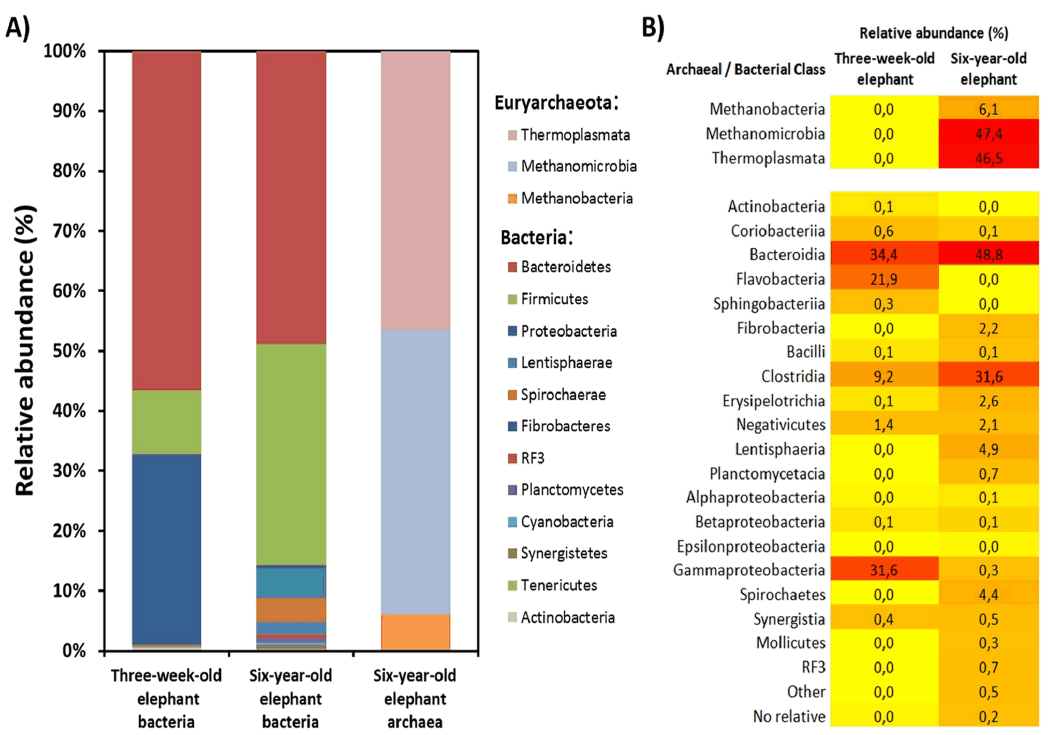
Figure 2. Relative abundances of different phyla and classes in the two elephant feces samples. A: Relative abundance of phyla in the feces of the three-weeks-old and the six-years-old Asian elephant based on 16S rRNA gene sequences. For the three-weeks-old elephant no Archaea were observed. B: Phylogenetic comparison on class level between both elephants. Heat map colors indicate the abundances of the respective 16S rRNA genes.